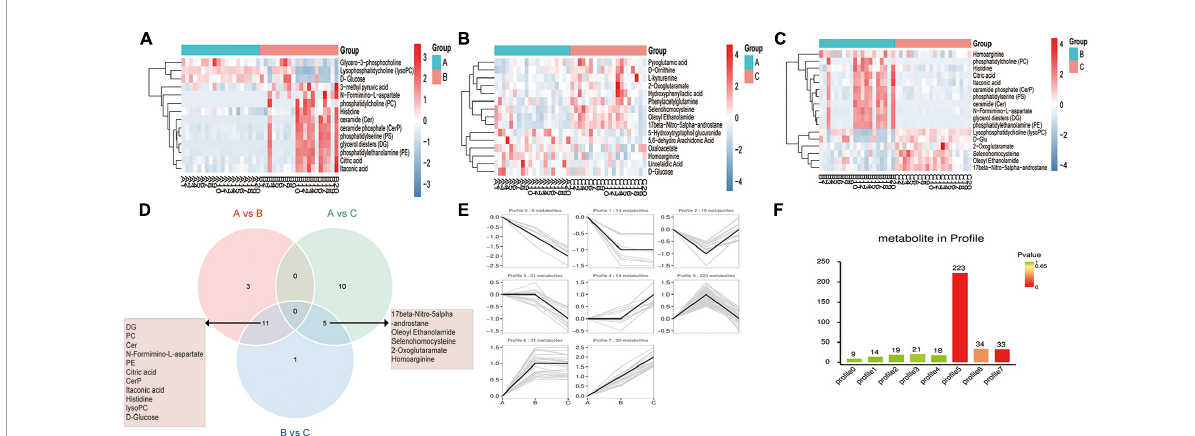
FIGURE2 Metabolic patterns in healthy control, HZ, and PHZ groups. (A–C) The heatmap of differential expressed metabolites (DEMs) between groups: (A) Groups A vs. B, identifying 14 DEMs, (B) group A vs. C, identifying 15 DEMs, and (C) groups B vs. C, identifying 17 DEMs. Red represents increased expression; blue represents decreased expression. (D) Identification of significant common metabolites via Venn diagram. (E) The trend expression profile of metabolites in the three groups. The black line represents the trend line, and the gray line represents the expression trend of each metabolite. (F) Number of metabolites in the profile. The height of the column represents the number of metabolites, and the color of the column represents the P -value.